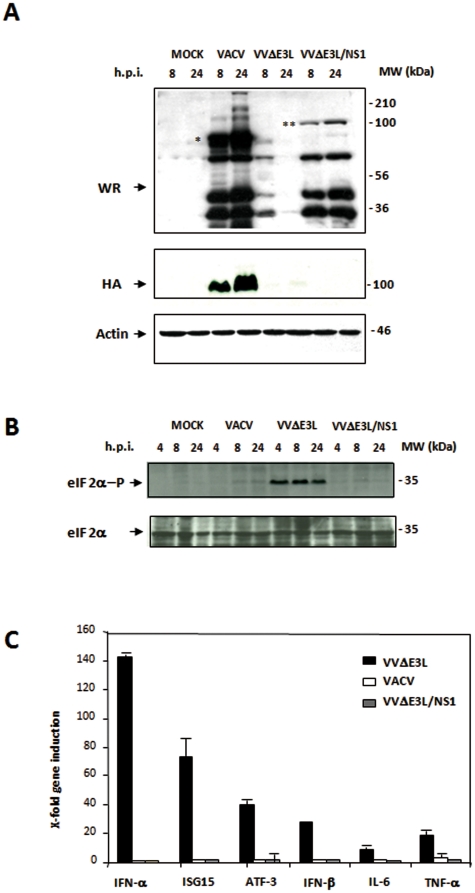
VVΔE3L/NS1 blocks eIF-2α phosphorylation and proinflammatory cytokine production in infected HeLa cells.
A. Viral protein expression. HeLa cells were mock-infected (MOCK) or infected with VACV, VVΔE3L or VVΔE3L/NS1 (5 PFU/cell). Cells were collected at the indicated times p.i., and equal amounts of total protein from cell extracts were separated by SDS-PAGE, transferred to nitrocellulose, and treated with a polyclonal antibody against a VACV recombinant virus that expresses the β-galactosidase gene. An anti-VACV HA antibody was used to confirm the lack of expression of this protein by the recombinant viruses. Actin was used as a protein loading control. The position of HA in VACV infected cells is indicated by an asterisk. The position of β-galactosidase protein observed in VVΔE3L/NS1 is denoted by two asterisks. B. eIF-2α phosphorylation levels during VACV, VVΔE3L or VVΔE3L/NS1 infection. HeLa cells were mock-infected (MOCK) or infected with VACV, VVΔE3L or VVΔE3L/NS1 (5 PFU/cell). Cells were collected at the indicated times p.i., and equal amounts of total protein from cell extracts were fractionated by SDS-PAGE, transferred to nitrocellulose and incubated with antibodies to total eIF-2α or eIF-2α phosphorylated at Ser51. C. Relative expression levels of genes involved in the immune response determined by real time RT-PCR. HeLa cells were mock-infected (MOCK) or infected with VACV, VVΔE3L or VVΔE3L/NS1 (5 PFU/cell) and processed for real time RT-PCR at 6 h.p.i. The name of each gene product and the data values obtained in RT-PCR are indicated. X-Fold gene induction (x-axis) was quantified by real time RT-PCR in three independent experiments. Standard deviation is indicated.